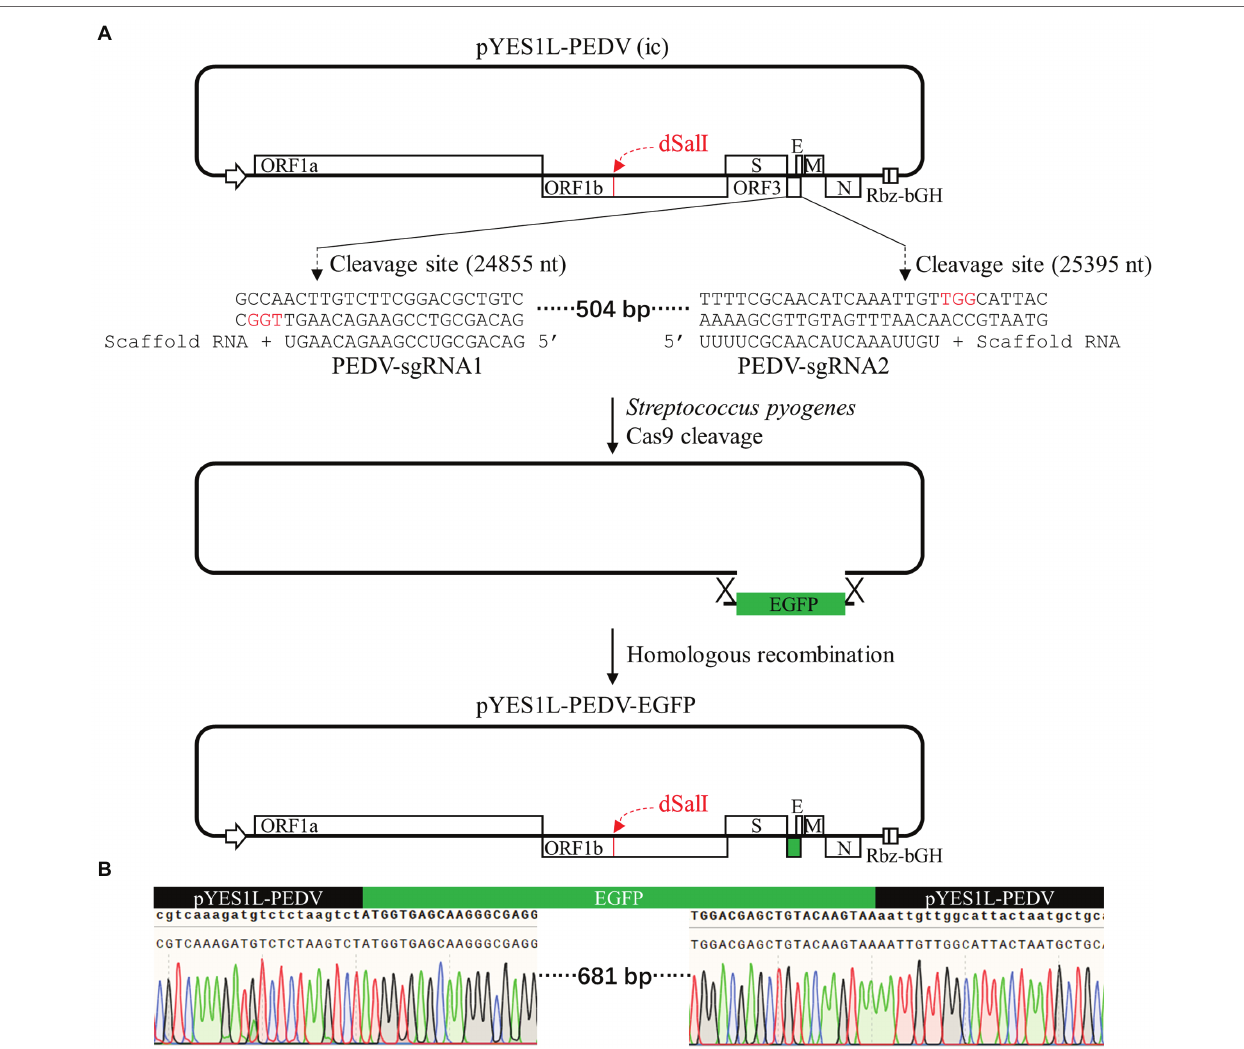
FIGURE 5 | Construction of a porcine epidemic diarrhea virus (PEDV) cDNA clone expressing EGFP with ORF3 swapped. (A) The schematic diagram of CRISPR/ Cas9 editing PEDV cDNA clone. pYES1L-PEDV was linearized using Streptococcus pyogenes Cas9 nuclease with two guide RNAs, PEDV-sgRNA1 and PEDV- sgRNA2. The homologous arms with this linearized cDNA clone backbone (>20 nt) at both terminals of the EGFP gene were introduced by primers EGFP-F and EGFP-R. This EGFP gene was assembled into a linearized cDNA clone backbone through homologous recombination using HiFi DNA assembly master mix (NEB), and the resulting plasmid was designated as pYES1L-PEDV-EGFP. (B) Verification of the EGFP insertion by DNA